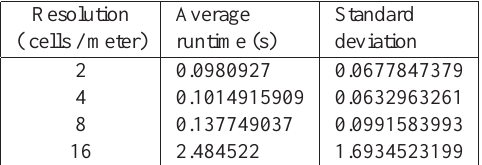
Table 1: Runtime of correspondence assignment for an indoor environment on a single core of an Intel Core2 Duo (2.4GHz) processor.